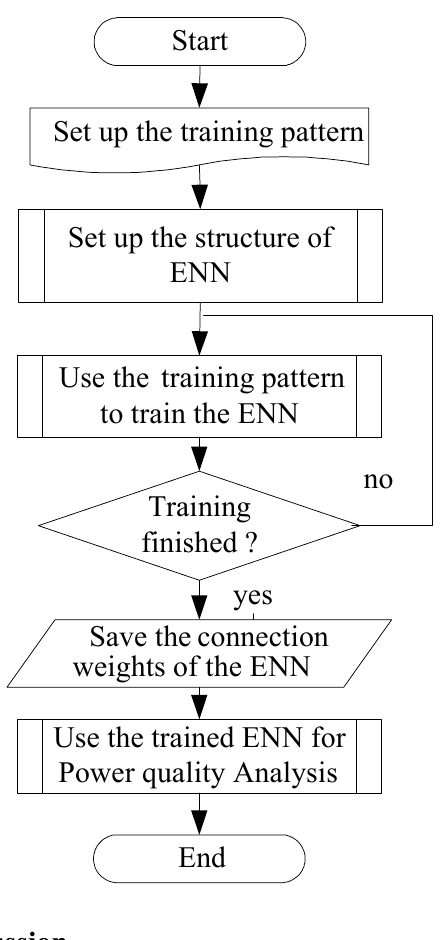
Figure 5. Overall operation flowchart of ENN.